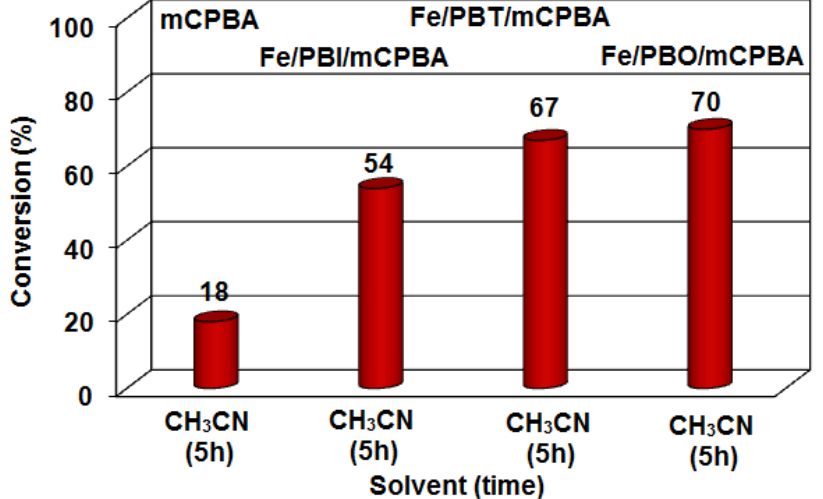
Figure 4. Comparison of the efficiency for the oxidation of cyclohexanone employing [Fe II (PBO) 2 (CF 3 SO 3 ) 2 ] ( 1 ), [Fe II (PBT) 2 (CF 3 SO 3 ) 2 ] ( 2 ), and [Fe II (PBI) 3 ](CF 3 SO 3 ) 2 ( 3 ) as catalysts. Reaction conditions: [Fe] (0.01 mM), cyclohexanone (10 mM), mCPBA (150 mM), CH 3 CN (5 mL), 60 °C, 5 h. Table 4. Comparison of the efficiency for the iron(II)-catalyzed Baeyer–Villiger oxidation of cyclohex- anone with mCPBA 1